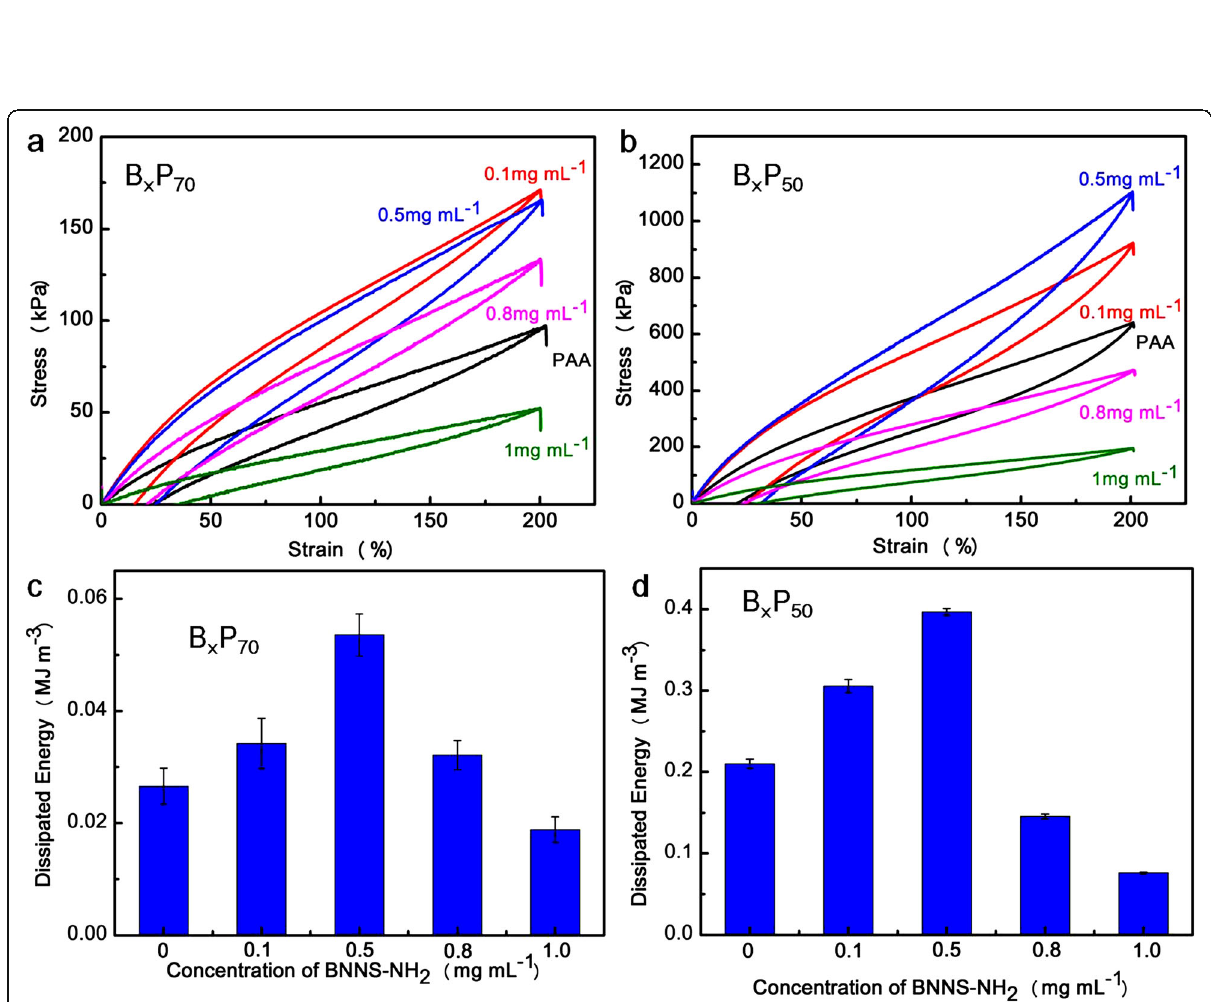
Fig. 6 Cyclic tensile of loading-unloading curves of a B x P 70 and b B x P 50 ; the dissipated energy of c B x P 70 and d B x P